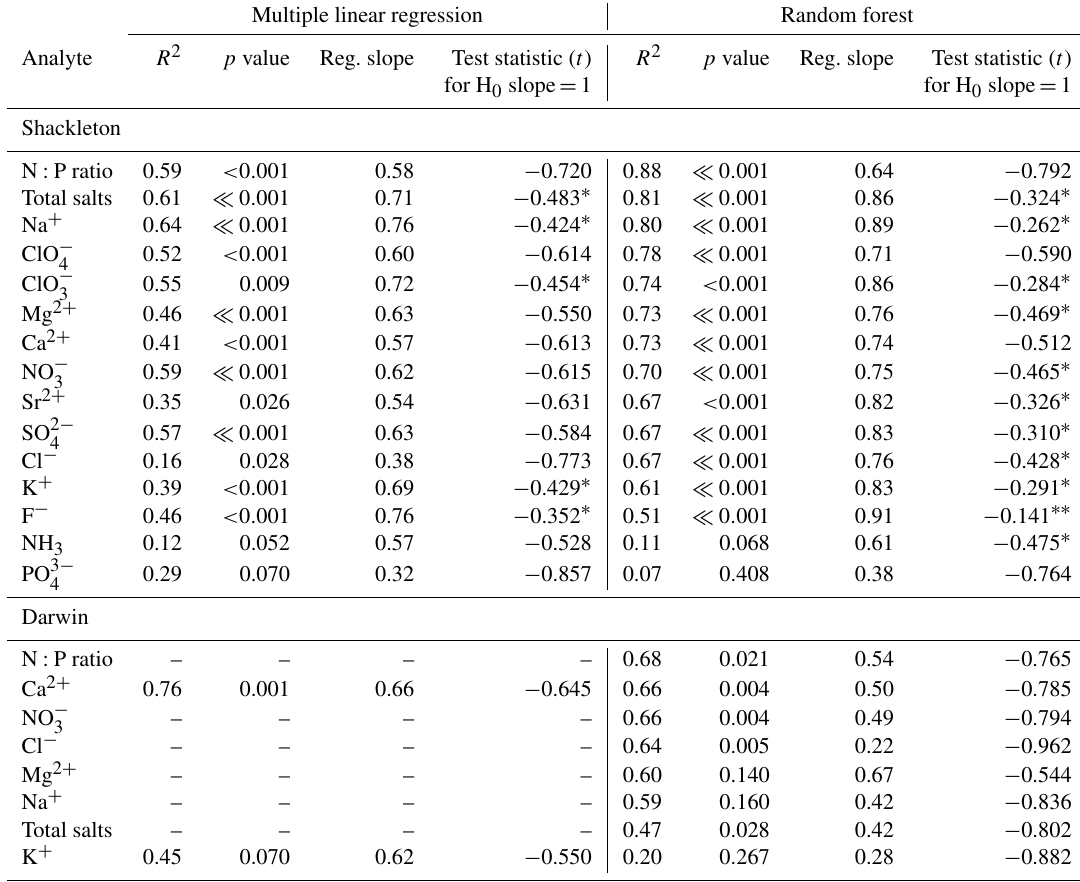
Table 3. Multiple linear regression and random forest statistics between predicted and measured concentrations from the Shackleton and Darwin Glacier regions. R 2 and p values are reported for the correlations between measured and predicted concentrations. Regression slopes and test statistic values ( t ) were calculated using the smatr library (Warton et al., 2012) in R to evaluate the null hypothesis (H 0 ) of slope = 1. Higher test statistic values (closer to 1) indicate that we reject the null hypothesis. All geochemical data were